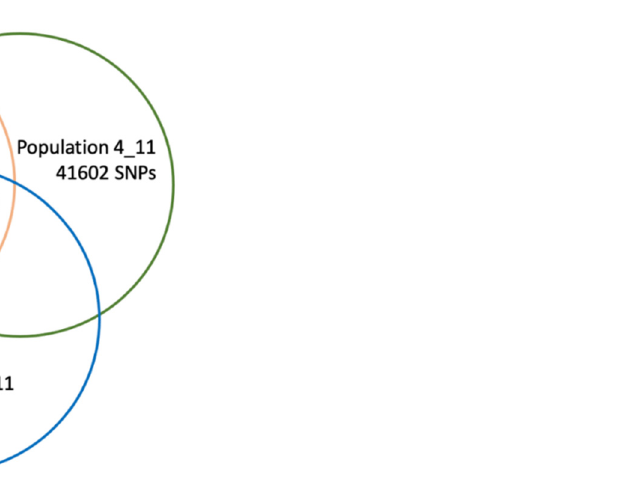
Figure 3. A Venn diagram showing overlapping SNP sets identified when aligning Illumina reads of the hybrid populations 2-11, 3-11, and 4-11 to V. vinifera 12× genome assembly using Stacks. About 17% of SNP missing data were detected across all 152 plants genotyped. The highest number of heterozygous SNP markers were discovered in the female genotype M.